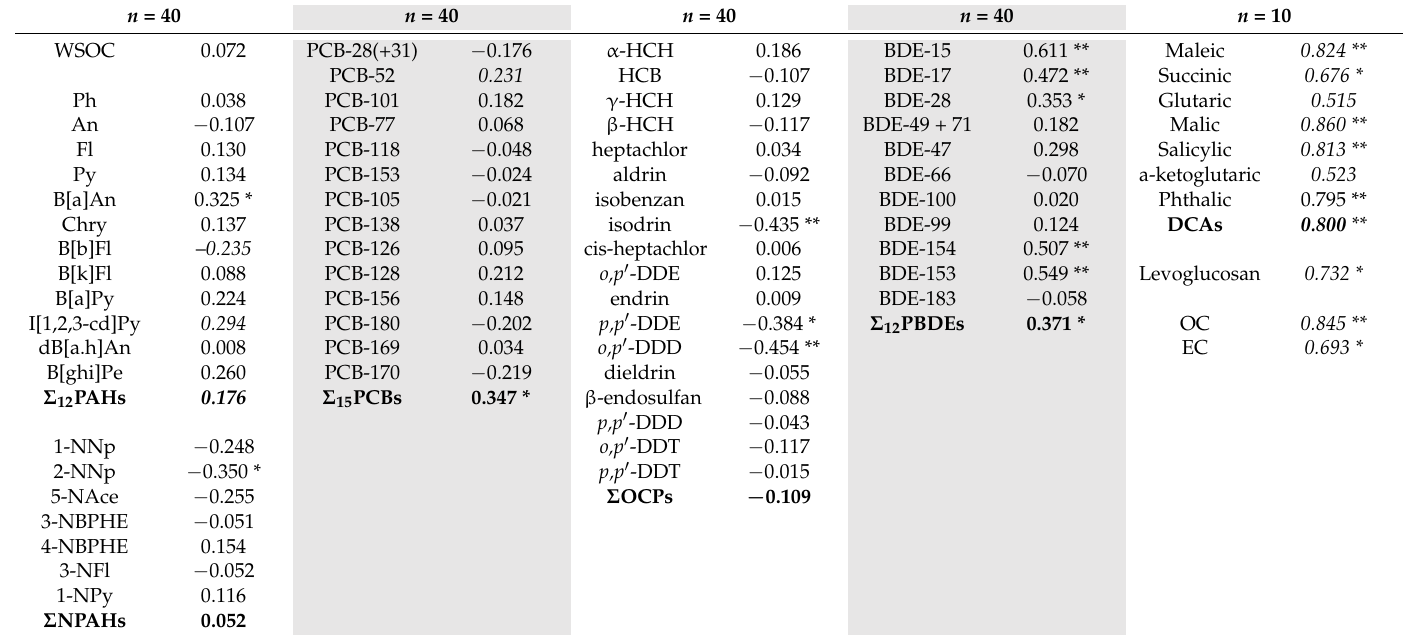
Table 3. Spearman and Pearson (italicized values) correlation coefficients between the mass-normalized DTT activity and the content of organic chemical components in PM from the urban background site